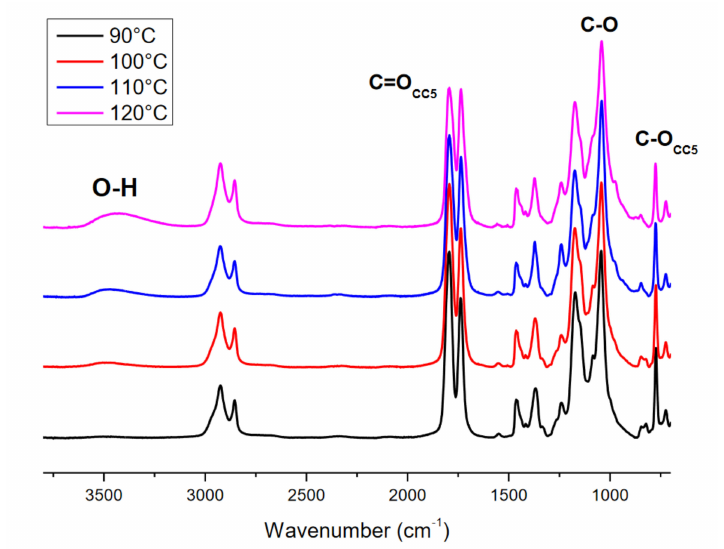
Figure 6. FT-IR spectrum of CELO at different